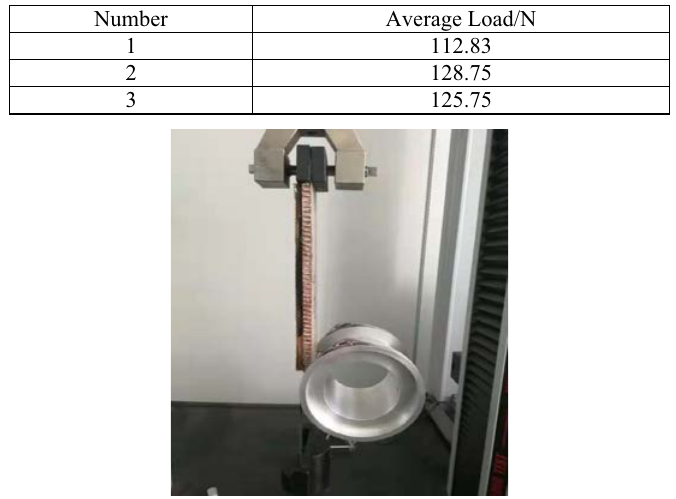
Table 5. Sample test result.